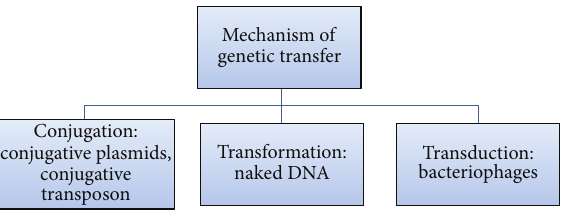
Figure 3: Showing different mechanisms of genetic